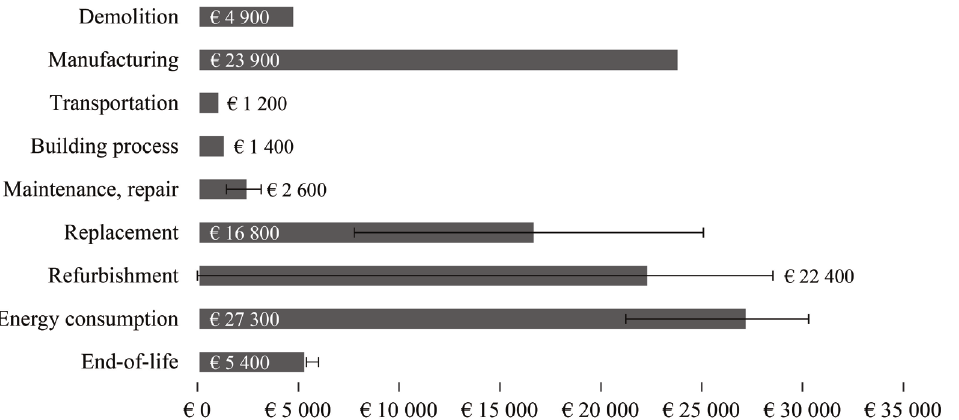
Figure 9. The analysis of the environmental impacts of the different life cycle stage of the transformation strategy with internal insulation of a cluster of modules (with a floor area of 433 m 2 ) indicates the life cycle stages with the most significant impact. The error bars represent the results of the sensitivity analysis on a variable lifespan of the building (from 30 to 79